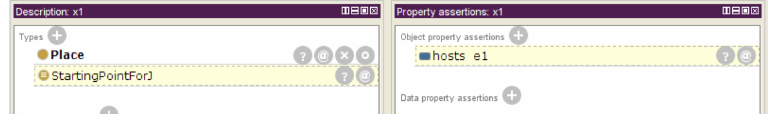
Figure 9. x 1 is classified as the StartingPointForJ.